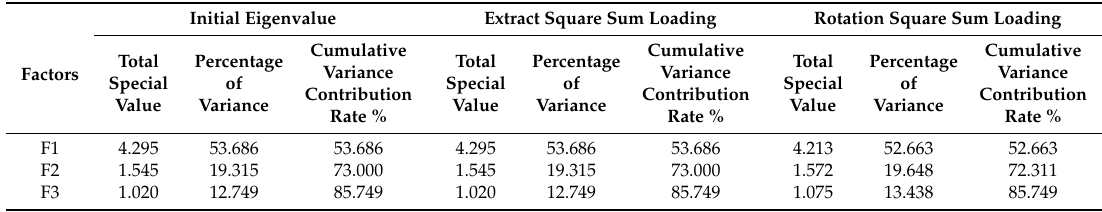
Table 7. Eigenvalues and cumulative contribution rates ( N = 60).